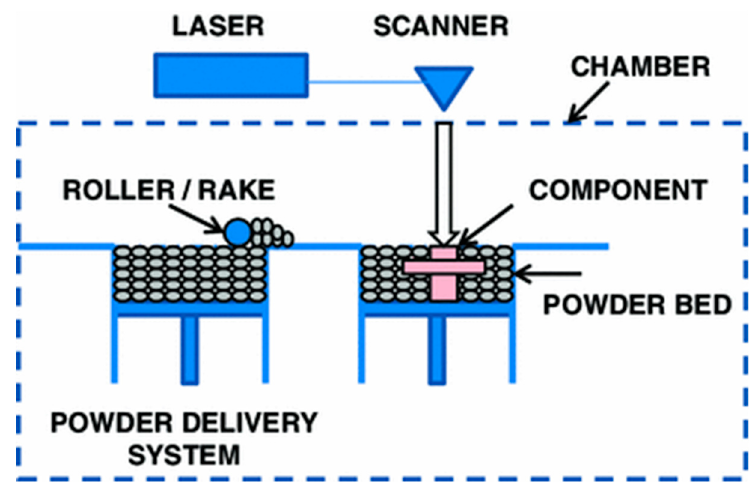
Figure 1. Illustration of the SLM process [5].